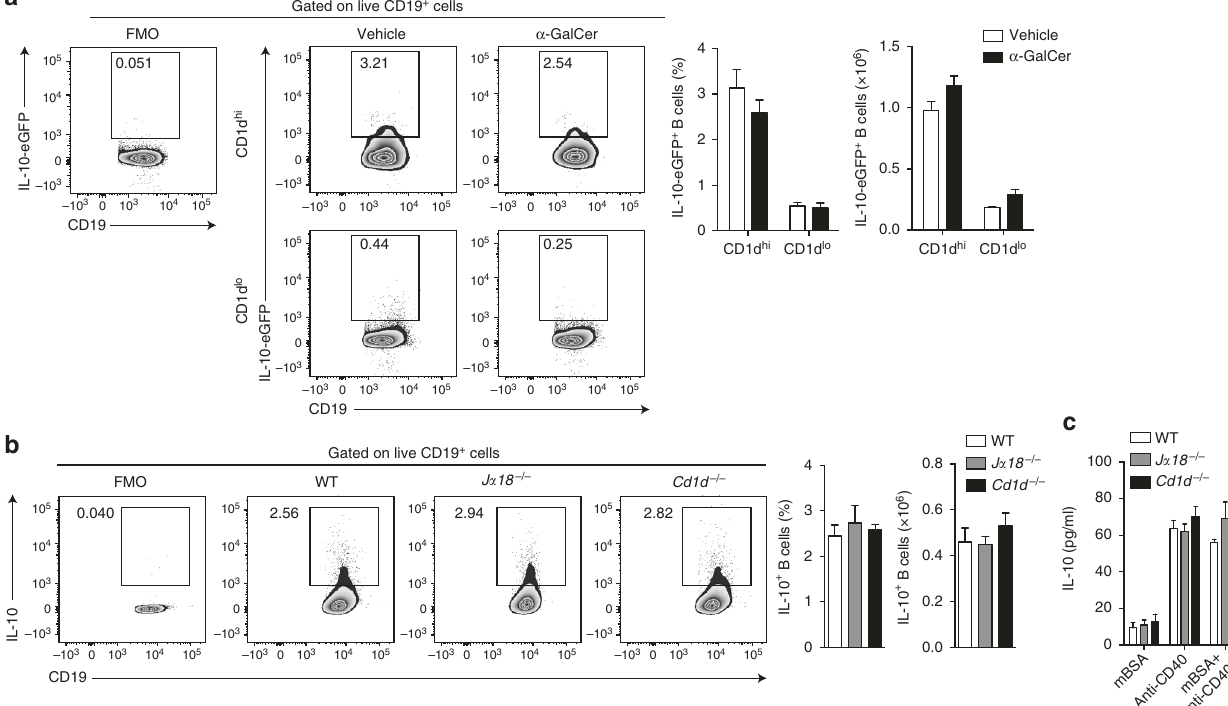
Fig. 8 Regulatory B cell development and in vitro suppressive capacity are not impaired in iNKT-cell-de fi cient mice. a Representative fl ow cytometry plots and bar charts showing the frequency and number of splenic IL-10-eGFP + CD19 + B cells from IL-10-eGFP mice that received α -GalCer or vehicle alone following induction of arthritis ( α -GalCer-treated group n = 4, vehicle-treated group n = 3, one of two experiments is shown). b Representative fl ow cytometry plots and bar charts showing the frequency and number of splenic IL-10 + CD19 + B cells in J α 18 − / − , Cd1d − / − , and WT mice following arthritis ( J α 18 − / − n = 5, Cd1d − / − n = 8, and WT n = 9, one of two experiments is shown). c Bar chart showing IL-10 production by B cells isolated from the spleens of arthritic J α 18 − / − , Cd1d − / − , and WT mice following stimulation with methylated BSA (mBSA), anti-CD40, or mBSA+anti-CD40 as measured by ELISA ( n = 9 per group, one of three experiments is shown). a – c Cells isolated on day 7 post disease. Data are mean ± s.e.m. ( a , c two-way ANOVA; b